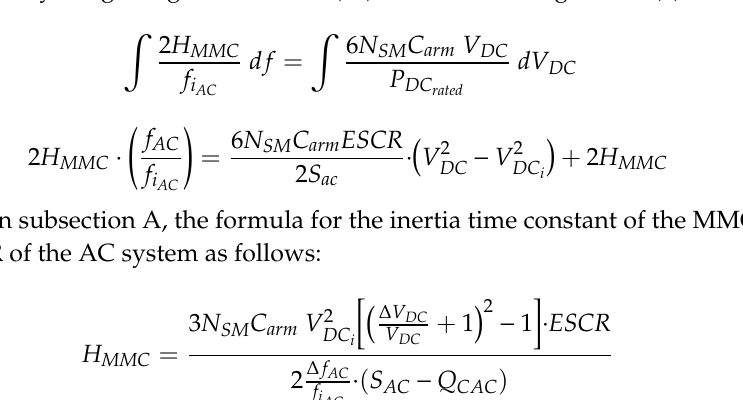
Table 1. System parameters.